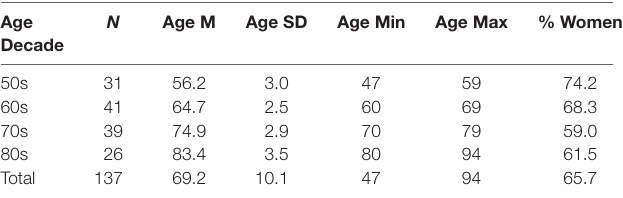
TABLE 1 | Age and gender details for each of the four age-decade groups formed.